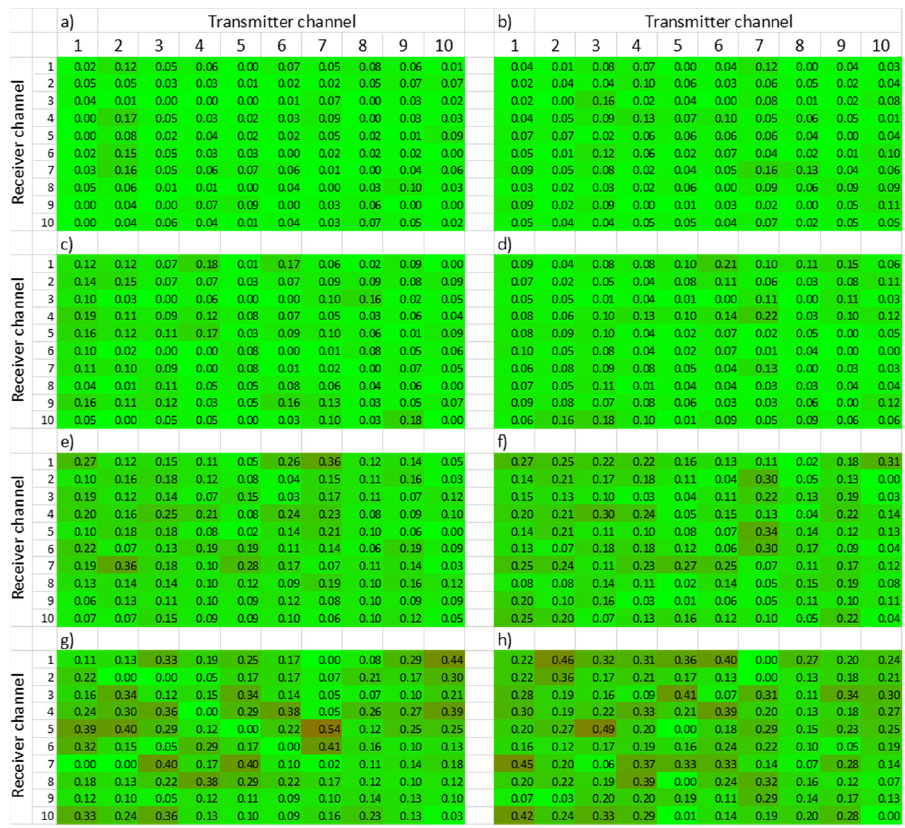
Figure 9. DoH matrices from the aluminum structure obtained on a weekly basis during the eight weeks of the test campaign. ( a – h ) weeks 1–8.